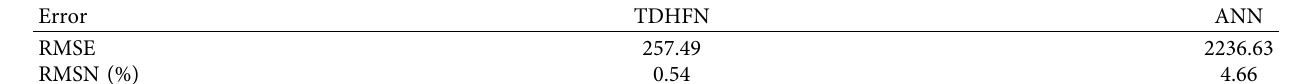
Figure 11: Comparative analysis with the ANN method. Table 5: RMSE and RMSN of TDHFN compared with the ANN method.